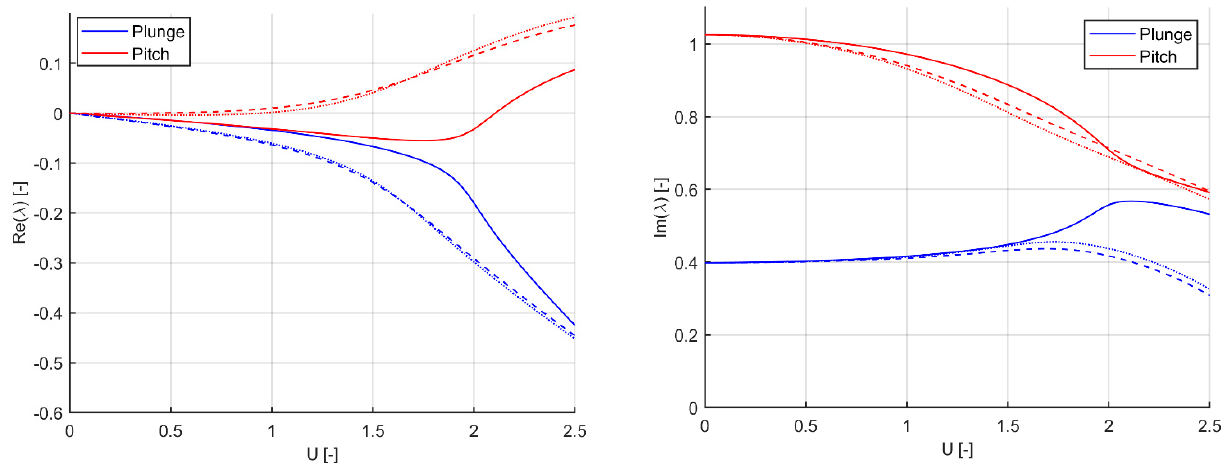
Figure 4. Evolution of the complex eigenvalues for Case A: real part ( left ), imaginary part ( right ); continuous, dashed and dotted lines for QU, QS and SQS aerodynamic models, respectively.